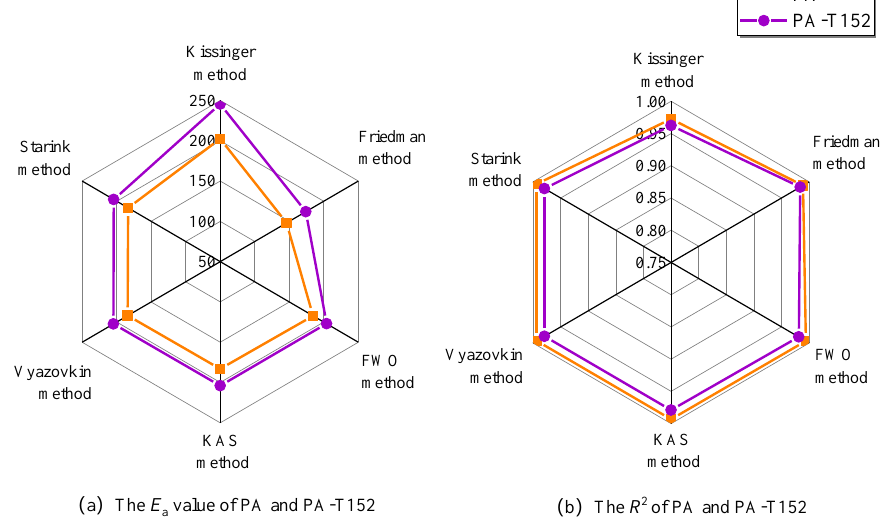
Figure 9. Radar plots of E a values and R 2 calculated by different thermokinetic methods. By the same calculation, the average E a of PA-T152 obtained by the four thermokinetic calculation methods is 204.15 kJ/mol, which has increased compared with the average E a of pure PA (183.72 kJ/mol). It has been proven that after adding the T152 emulsifier, the E a of PA is improved, that is, the stability of PA-T152 becomes